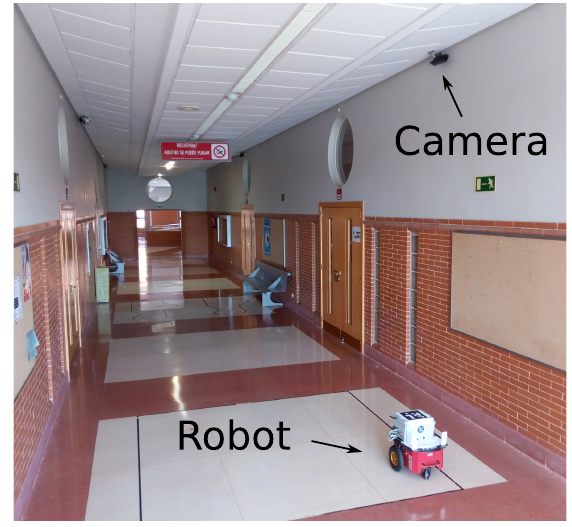
Figure 6. Picture of the working area with a P3-DX robot and Kinect 2 camera